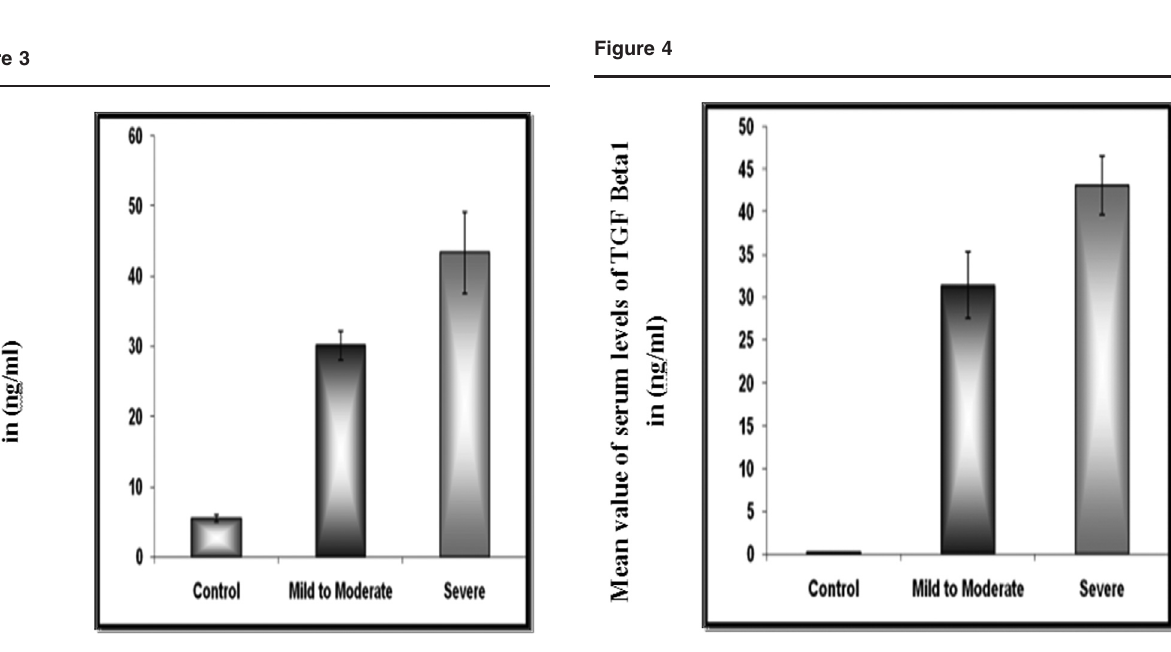
Statistical comparison of range, mean±SD values of bronchoalveolar lavage fluid levels of transforming growth factor β 1 (ng/ml) in the three studied